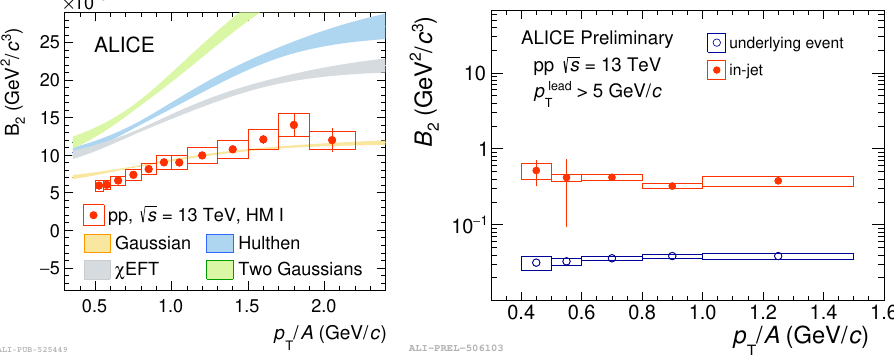
Figure 1. Left. Comparison between measurements and theoretical predictions for the coalescence parameter B 2 for (anti)deuterons as a function of p T / A . Theoretical predictions are obtained using di ff erent wave functions to describe nuclei: Gaussian (yellow), Hulthen (blue), χ EFT (gray) and two Gaussians (green). Right. Coalescence parameter B 2 in jets (full markers) and in the underlying event (empty markers) as a function of p T / A